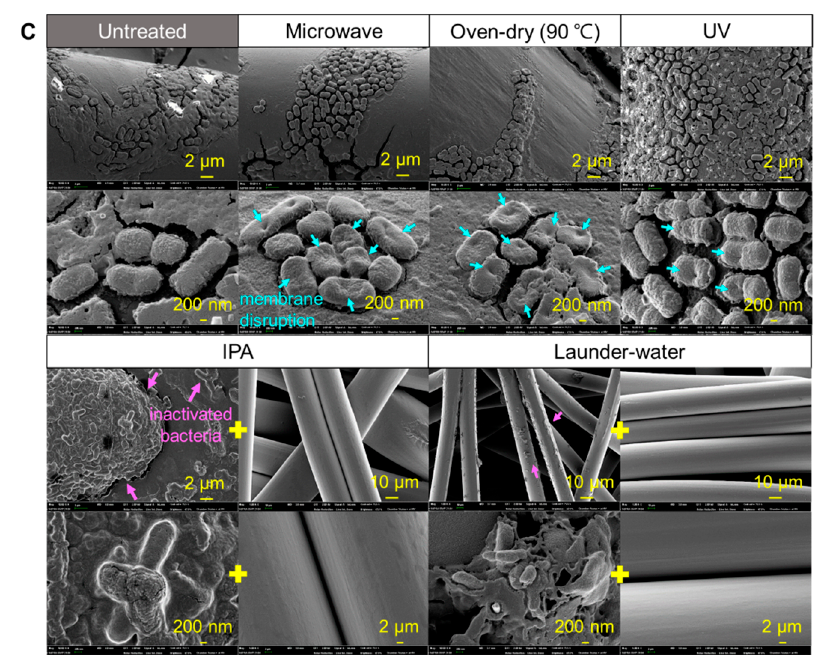
Figure 6. Numerical analysis of bacteria for each layer of Resp. A with varied treatments. ( A ) Monochrome calibrated images of coverweb and stiffener with bacteria cells, and ( B ) quantification of live E. coli remaining on each layer with and without disinfection treatments. As the bacteria was unable to penetrate through meltblown filter web and inner web, the images of only coverweb and stiffener are presented. ( C ) FE-SEM images of loaded bacteria after microwaving, oven-dry, UV irradiation, IPA immersion, and water-laundering.